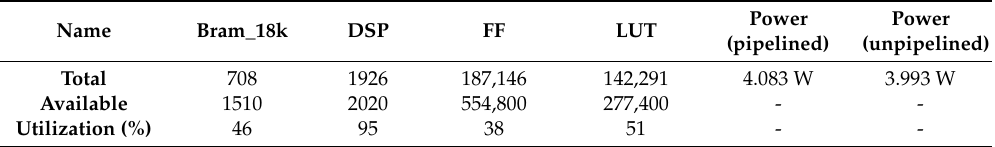
Table 2. Resource utilization of the